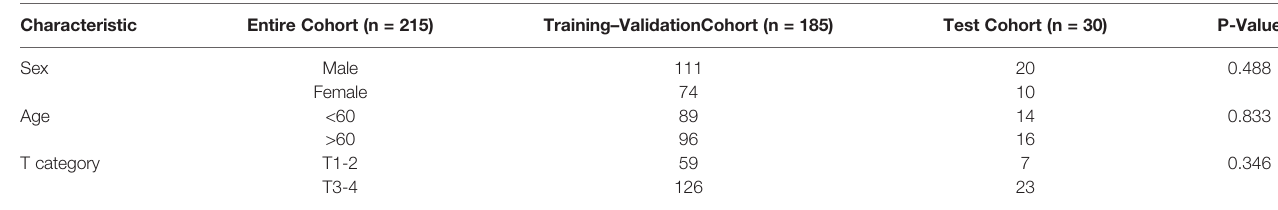
TABLE 1 | Patient